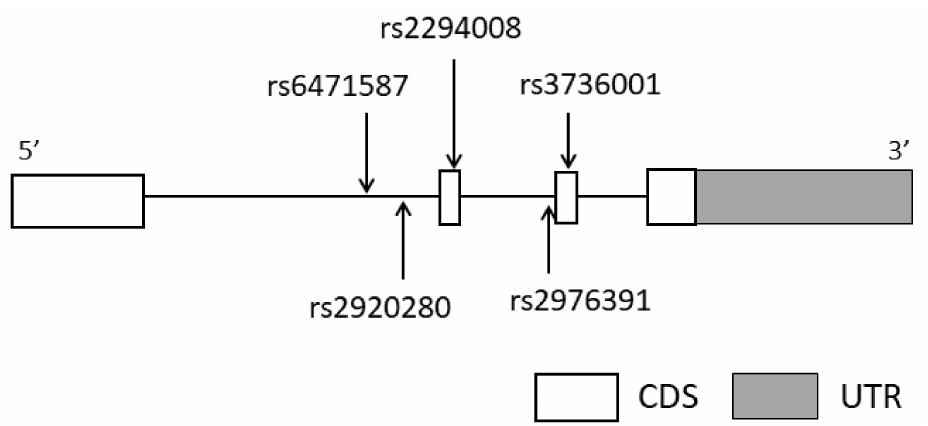
Figure 1. Gene structure and locations of the genotyped tag single-nucleotide polymorphism (SNP) sites in prostate stem cell antigen gene ( PSCA ). The horizontal bar indicates the genomic sequence of PSCA. Open boxes and lines represent exons and introns, respectively, with the widths not representative of the base-pair length. The dark gray box shows the untranslated region (UTR). Vertical arrows indicate genotyped tag SNP sites in this